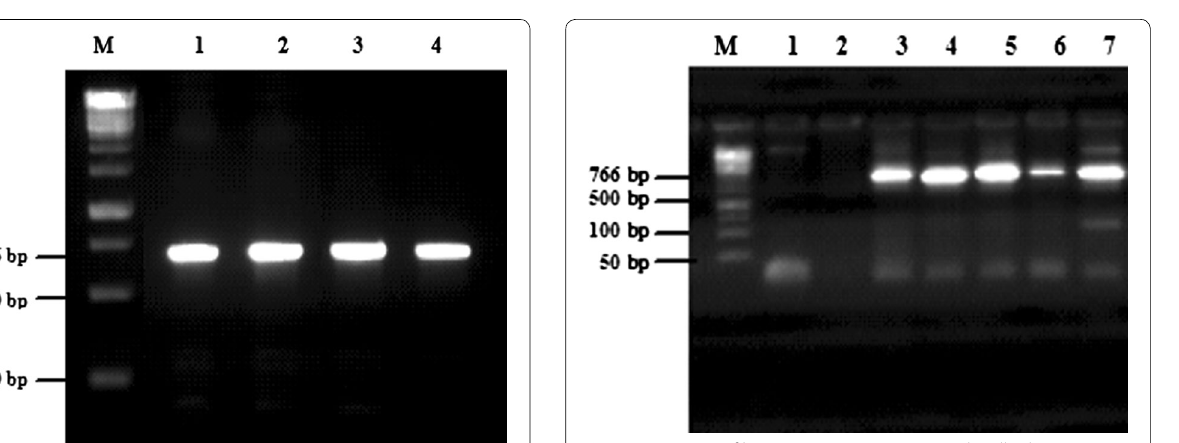
Fig. 4 Detection of bre174A sequences in Lactobacillus brevis. Detec- tion of bre174A sequences in 7 Lb. brevis isolates. Lane M: molecular weight marker 1kb; Lane 1: M2; Lane 2: M6; Lane 3: M1; Lane 4: M7; Lane 5: M8; Lane 6: M10; Lane 7: